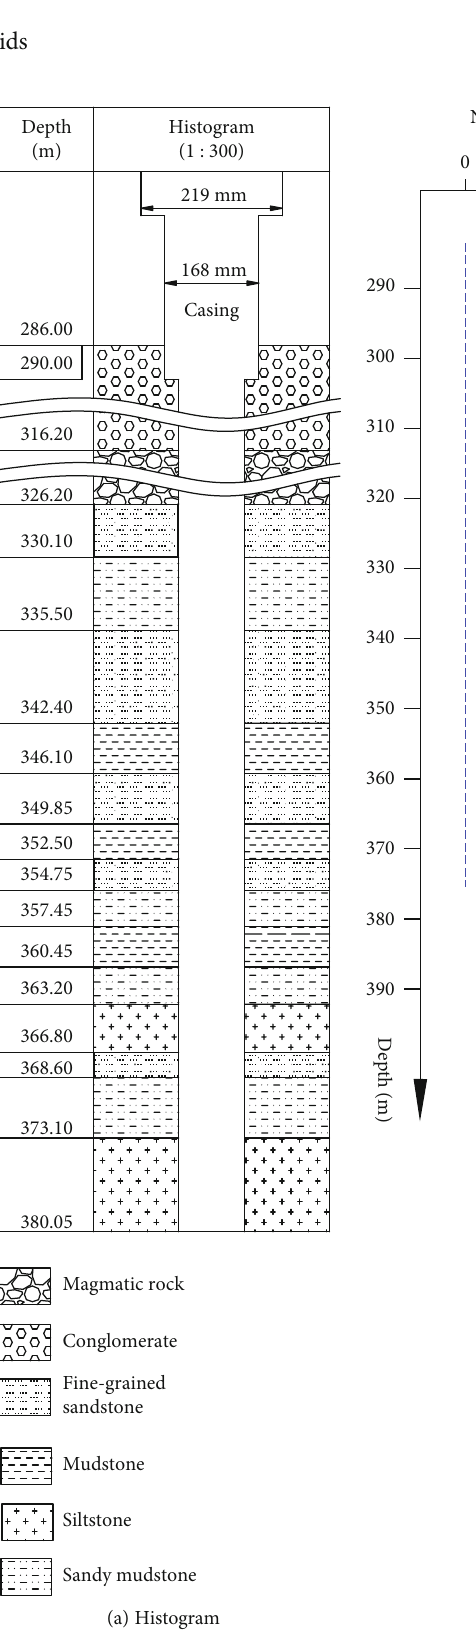
Figure 6: Flow curve diagram of the main shaft detection